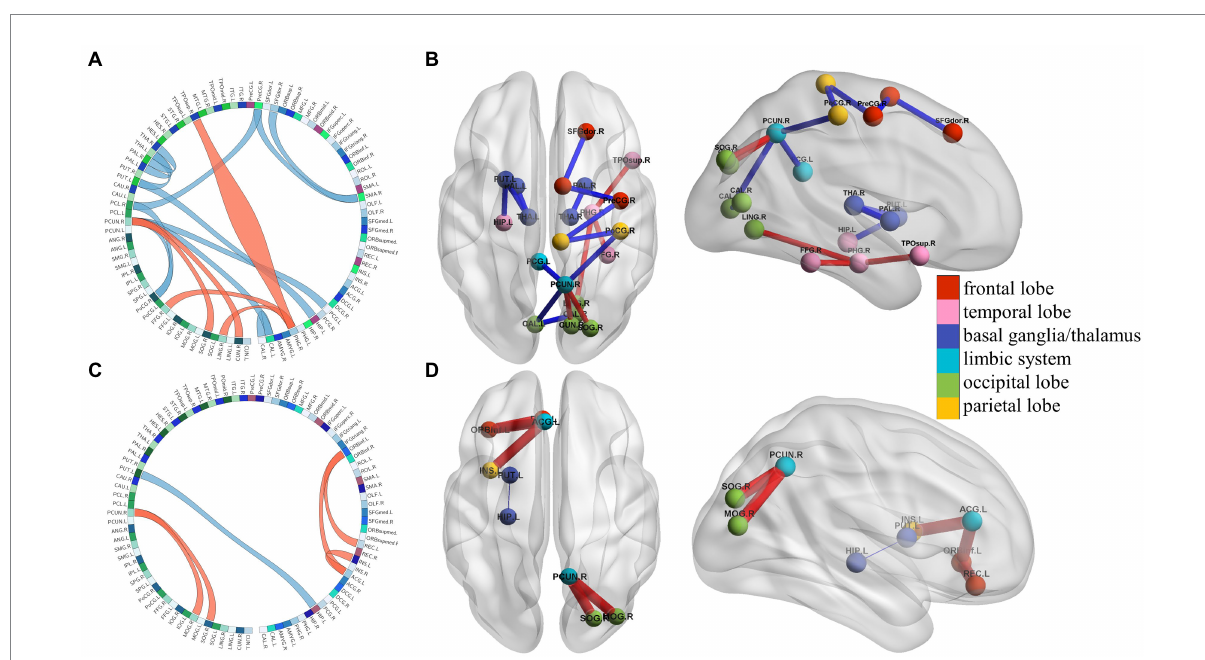
FIGURE 4 The results of connectome edge analysis. Ninety brain regions constitute the circle part of the circos diagram. Red lines represent the increase in the number of white matter fibers compared to the HC group, which are defined as positive connections, and blue lines represent the decrease in the number of fibers, which are defined as negative connections. The red and blue lines have the same meaning in (A–D) , (A,B) Significant differences in the number of white matter fibers in 90 brain regions between LAN and HC groups are shown. The brain regions of negative connections mainly involve the default mode network, sensorimotor network, dorsolateral prefrontal loop, basal ganglia and thalamus, and medial temporal lobe memory (MTL) system, and are related to cognition declines such as memory, language, abstraction, and visuospatial ability. The positive connections mainly involve brain regions between the precuneus and occipital lobe fibers and memory-related fiber connections, suggesting that the body compensates for hearing loss and cognitive decline. (C,D) Significant differences between RAN and HC groups are shown. Fibers between the left lenticular putamen and the left hippocampus were the only negative connection in RAN patients. The fibers belonging to the MTL system are associated with memory. Positive connection regions mainly involve the occipital lobe, the frontostriatal circuits, the salience network, and the MTL system, and are associated with the visual system, attention, cognition switching, and memory, revealing that the body presents anatomical fiber connection enhancement to compensate for cognitive declines such as attention and